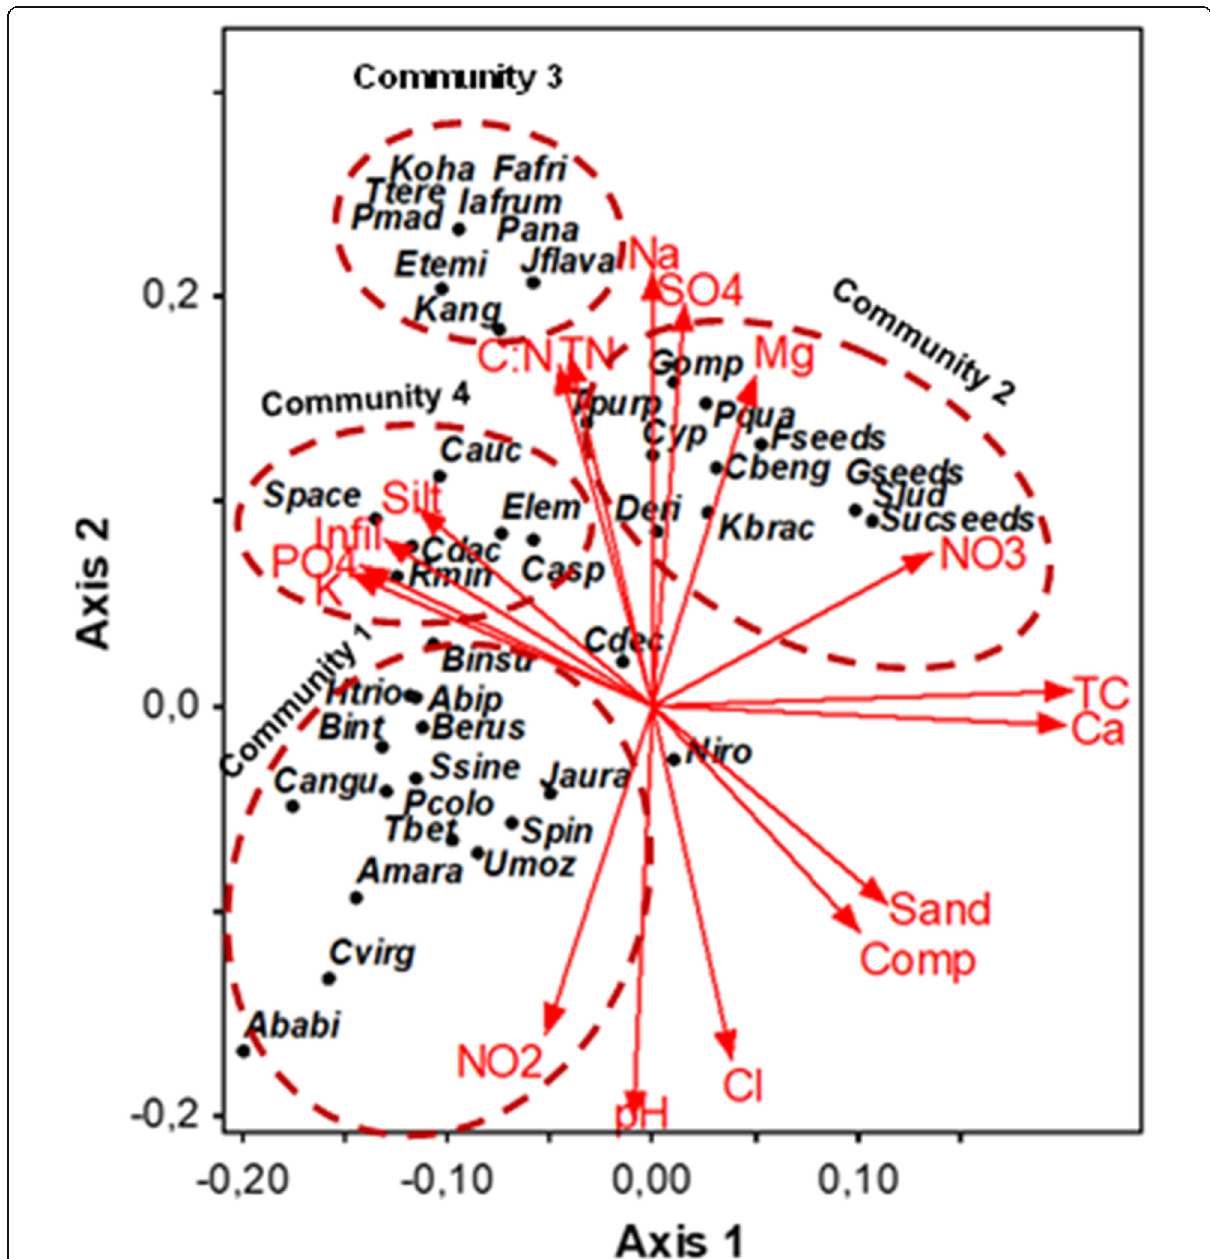
Fig. 5 Principal component analysis showing the relationships between soil properties and herbaceous species. Key to species: Ababi, Aristida congesta subsp. barbicollis ; Abip, Aristida bipartita; Berus, Brachiaria eruciformis ; Htrio, Hibiscus trionum ; Tbet, Tragus berteronianus ; Umoz, Urochloa mosambicensis ; Cvirg, Chloris virgata ; Cangu, Crabbea angustifolia ; Pcolo, Panicum coloratum ; Spin, Schkuhria pinnata ; Space, Setaria spacelata ; Sbisp, Sesbania bispinosa ; Sperm, Spermacoce sinensis ; Fafri, Fingerhuthia africana ; Hcont, Heteropogon contortus ; Sital, Senna italica ; Pmad, Phylanthus maderaspatensis ; Panau, Phylanthus uniraria ; Amara, Amaranthus hybridus ; Ttere, Tribulus terestris ; Binsu, Bothriochloa insculpta ; Niro, Nidorella resedifolia ; Etemi, Embrosia artemisifolia ; Bint, Blepharis intergrifolia ; Koha, Kohausia virgata ; Jflava, Justicia flava ; Cdac, Cynodon dactylon ; Rmin, Rhyncosia minima ; Cdec, Corbichonia decumbens ; Iafrum, Ischaemum afrum ; Casp, Chochorous asplenifolius ; Deri, Digitaria eriantha ; Elem, Eragrostis lehmanniana ; Cbeng, Commelina benghalensis ; Slud, Sporobolus ludwigii ; Cyp, Cyperus rotundus ; Kbrac, Kalanchoe brachyloba ; Tpurp, Tephrosia purpurea ; Cauc, Crabbea acaulis ; Kangu, Kypocarpa angustifolia ; Pquad, Portulaca quadrifida ; Jaura, Jamesbrittenia aurantiaca ; Ssine, Ipomoea sinensis ; Gomp, Gomphrena celocioides ; Fseeds, forb seedlings; Gseeds, grass seedlings; Sseeds, succulent seedlings. Key to soil properties: Comp, compaction; Infil,